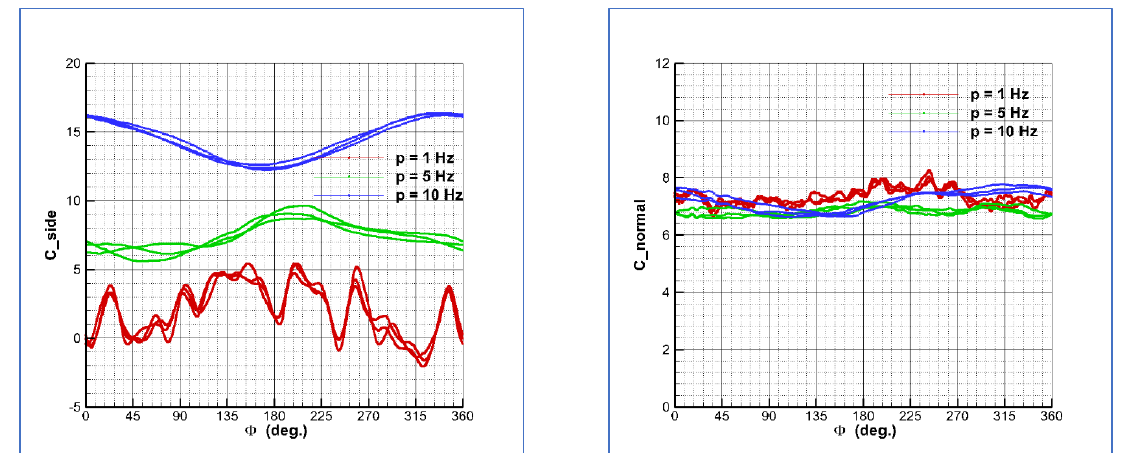
Figure 3. Side ( left ) and normal ( right ) force coefficients versus roll angle at the three different positive spin velocities. Last three cycles. Ma = 0.2, Re =2 × 10 6 and α = 45 deg.